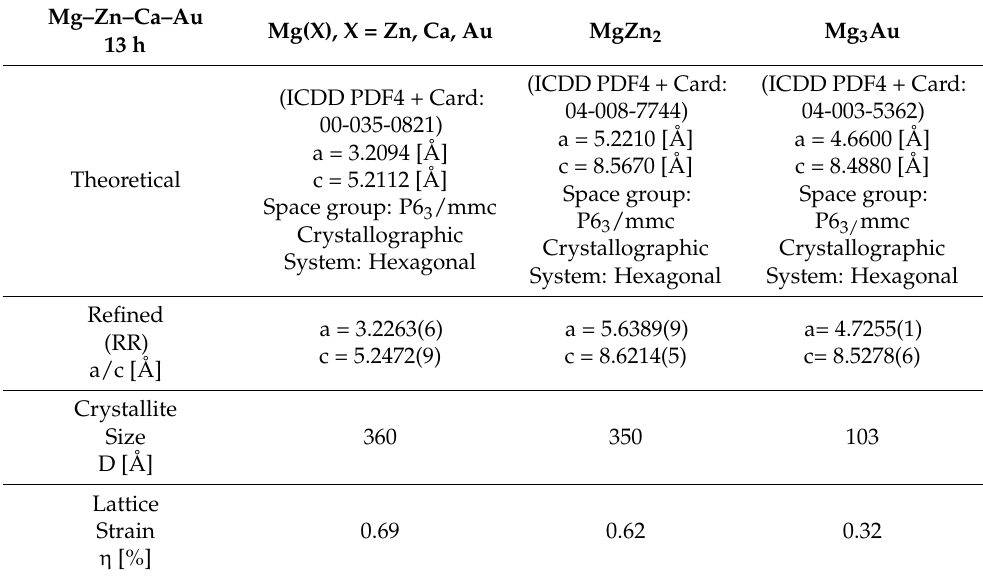
Table 1. Structural parameters, crystallite sizes and lattice strain for the main phases present in the Mg–Zn–Ca–Au sintered